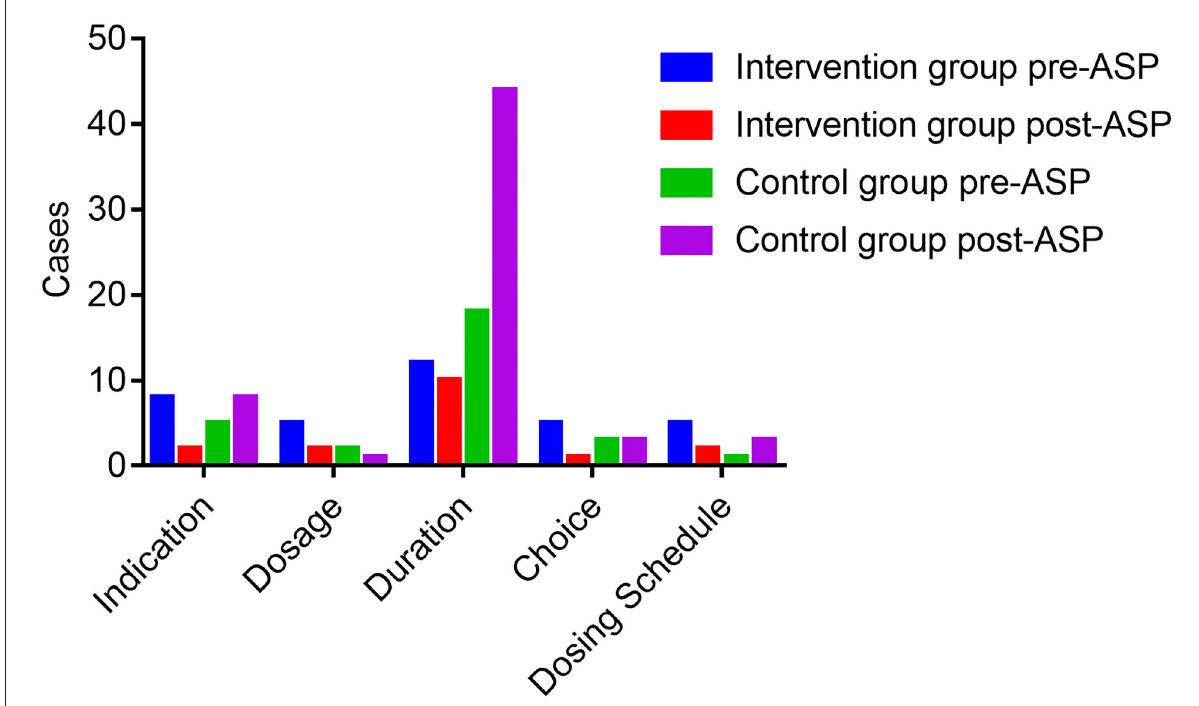
FIGURE1 Inappropriate use of antibiotics before and after the ASPs implementation in the hepatobiliary surgery ward. ASPs, antimicrobial stewardship